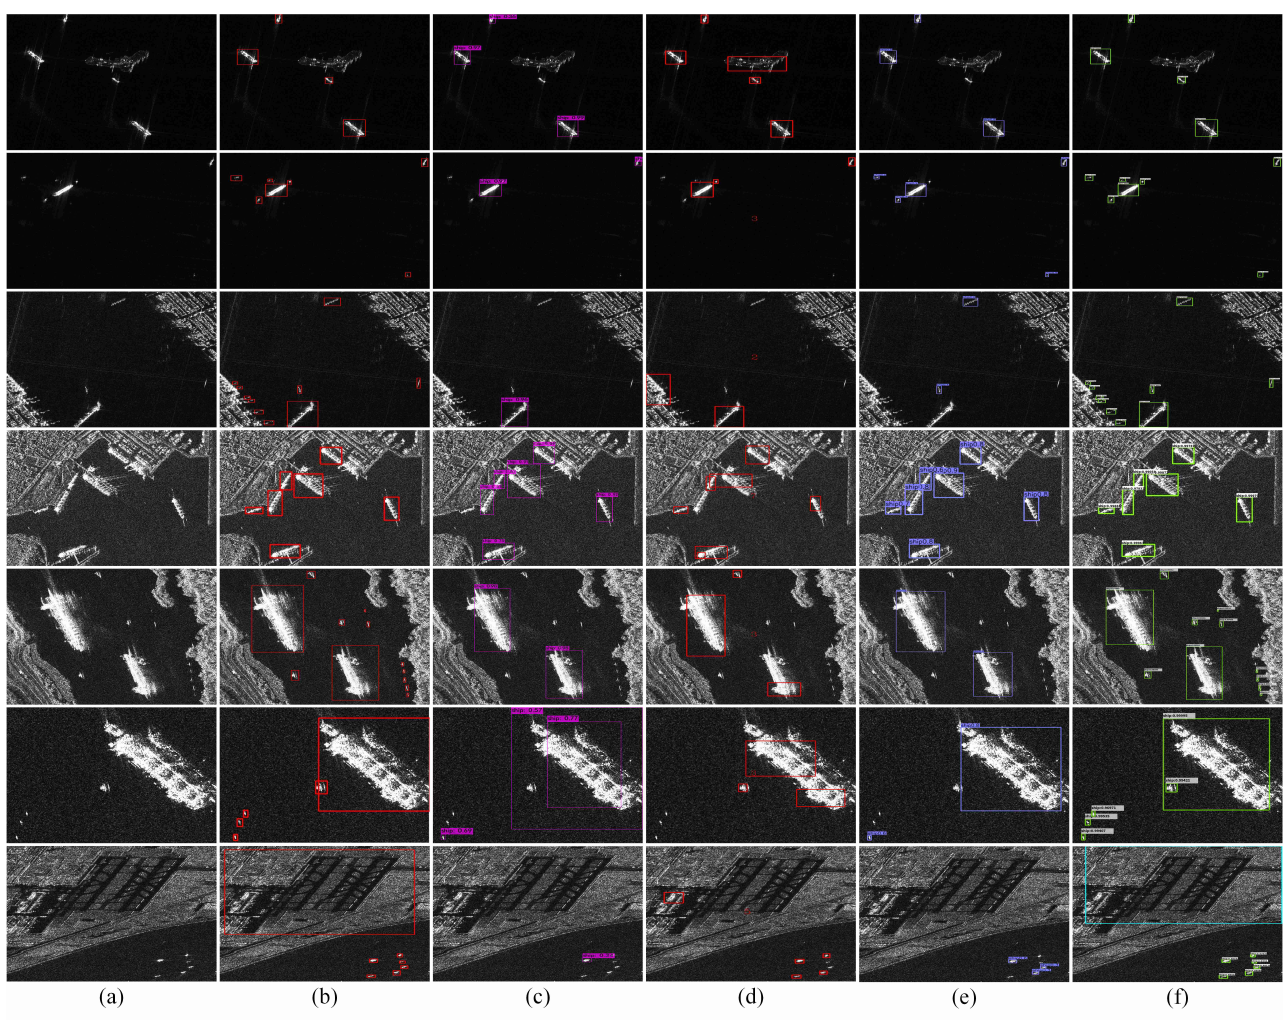
Figure 13. The proposed algorithm is compared with other advanced algorithms. ( a ) is the initial image. ( b ) is the image with the truth box. ( c , d , e ), respectively, represent the detection images of YOLOv4, DAPN, and SSE-CenterNet. ( f ) is the detection image of the proposed algorithm. As shown in the figure. There are targets with similar-scale differences, large-scale differences, and ultra-large-scale differences in the SAR